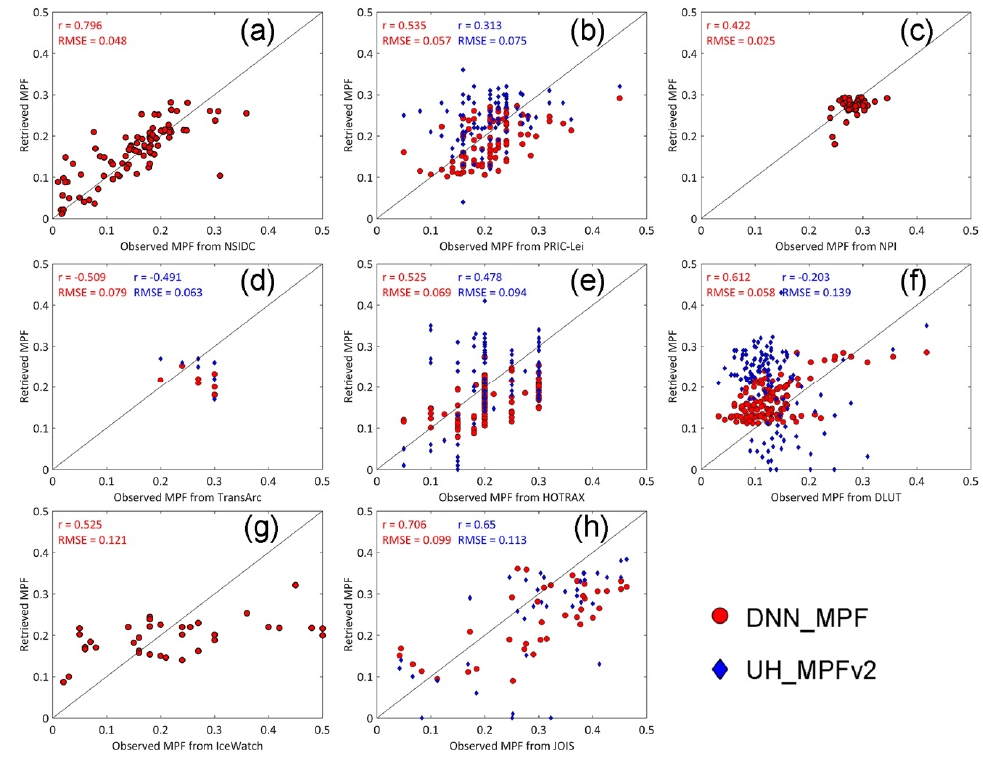
Figure 7. Validation of the DNN_MPF and UH_MPFv2 against the observed MPF on the 12.5 km polar stereographic grid. ( a ) NSIDC, ( b ) PRIC-Lei, ( c ) NPI, ( d ) TransArc, ( e ) HOTRAX, ( f ) DLUT, ( g ) IceWatch, ( h ) JOIS.